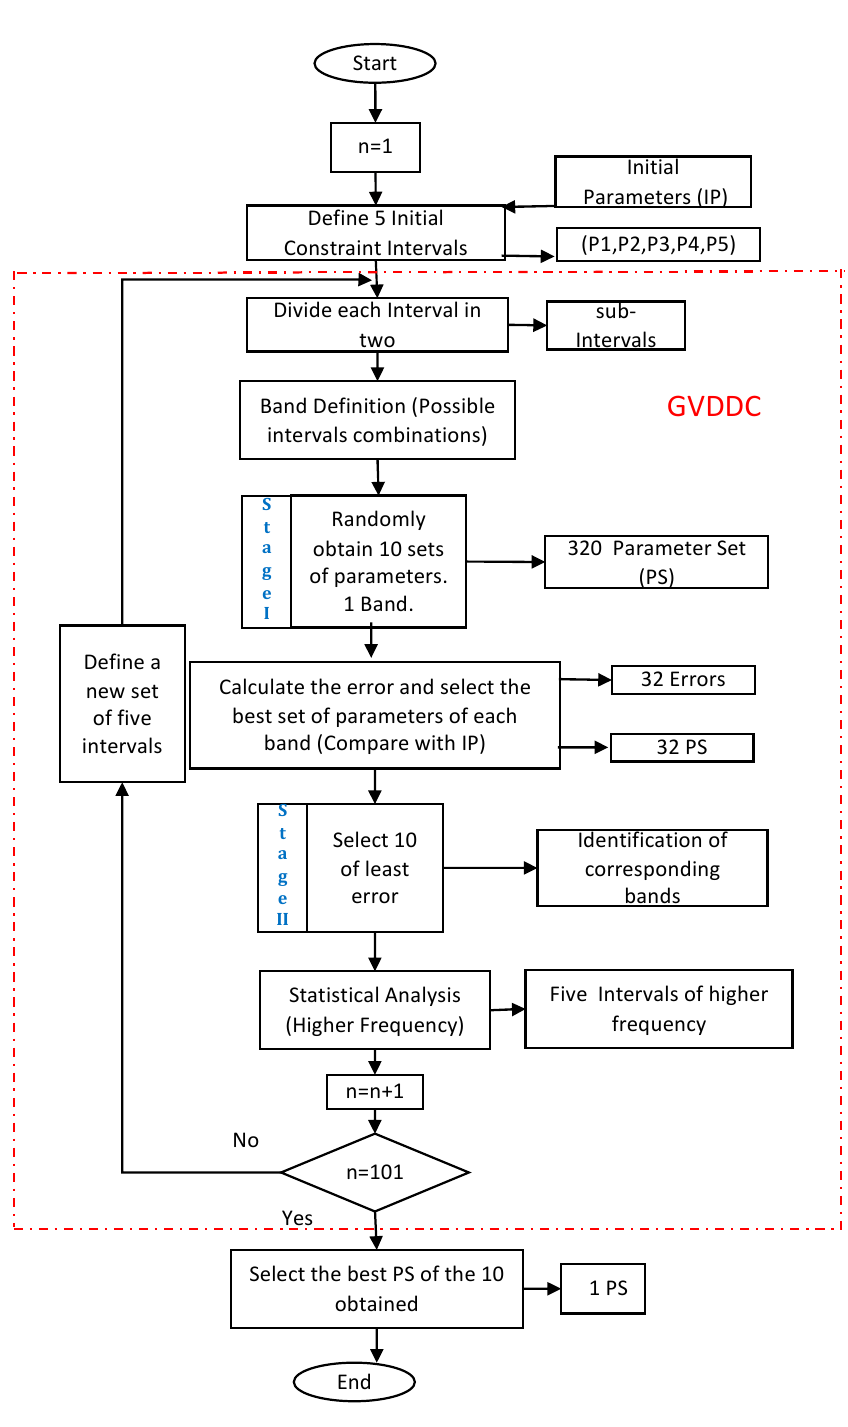
Figure 6. Flowchart of the process of stochastic search of the SSVDC technique.